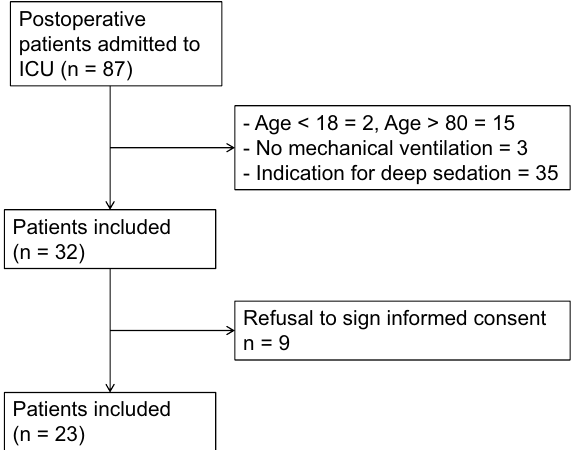
Figure 1. Enrollment flow diagram. Twenty-three postoperative patients with invasive mechanical ventilation in the intensive care unit (ICU) were finally included in the